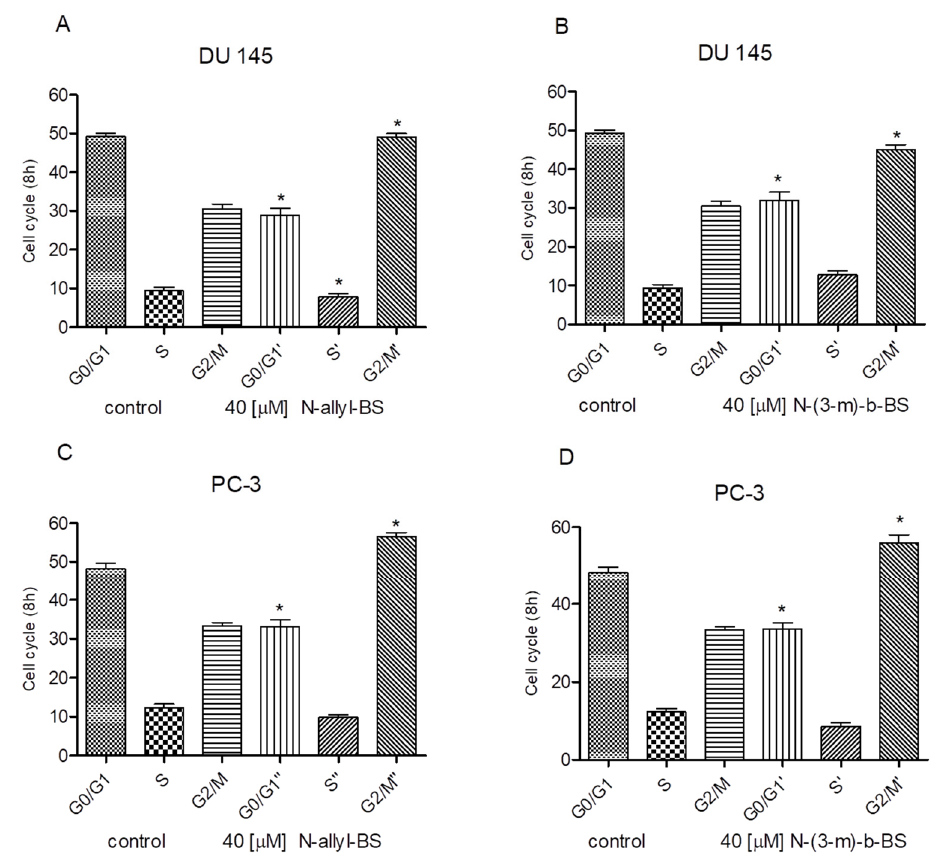
Figure 3. 40 µ M N -allyl-BS and N -(3-mb)-BS respectively induce G2 / M cell cycle arrest in prostate cancer cells DU145 ( A , B ), PC-3 ( C , D ), after 8h treatment. The data are presented as mean ± SE (n = 3). Significance of variations compared with control was calculated using one-way ANOVA followed by Bonferroni’s multiple comparison test. (*P < 0.01).